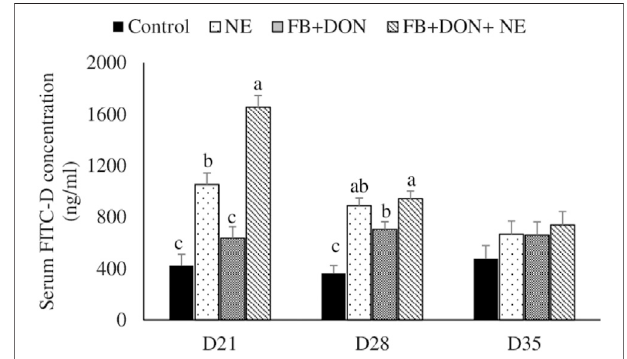
FIGURE 2 | Effect of subclinical dose of FB + DON and E. maxima/C. perfringens challenge on gut permeability to FITC-dextran. Day-old chicks were distributed into four treatment groups: control, necrotic enteritis (NE), fumonisin + deoxynivalenol (FB + DON), and FB + DON + NE groups. BirdsintheNEandFB+DON+NEgroupsreceived2.5×10 3 Eimeriamaxima oocyst per bird on day 14. All birds received 1 × 10 8 CFU/bird of Clostridium perfringens on days 19, 20, and 21. One bird/pen was orally gavaged with 2.2 mg/bird of 4,000 MW fl uorescein isothiocyanate dextran (FITC-D), and bloodwascollected2